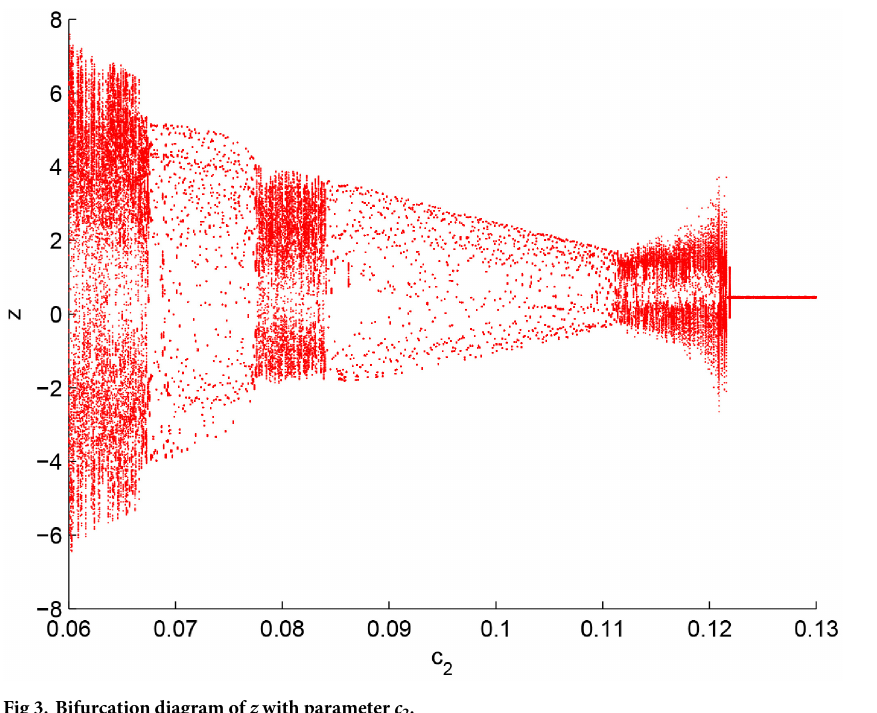
Fig 3. Bifurcation diagram of z with parameter c 2